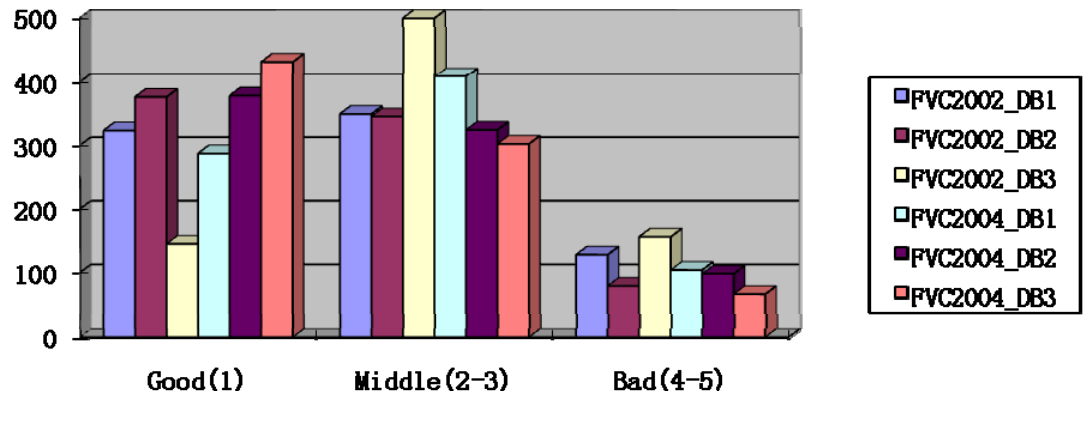
Figure 7. Quality distribution of the databases by the relabeled NFIS